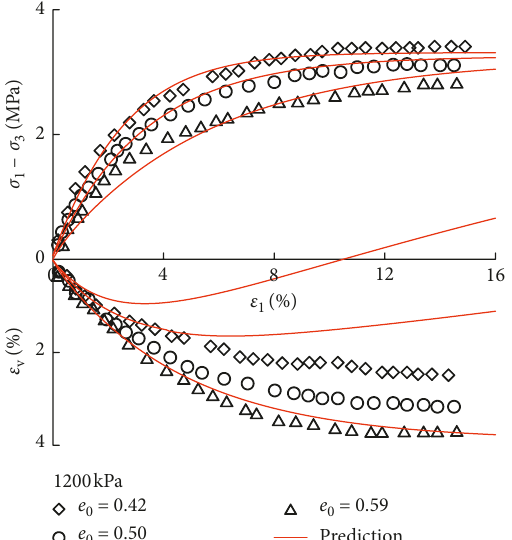
Figure 14: Experiment result and prediction of rockfill materials under 800 kPa confining pressure with different void